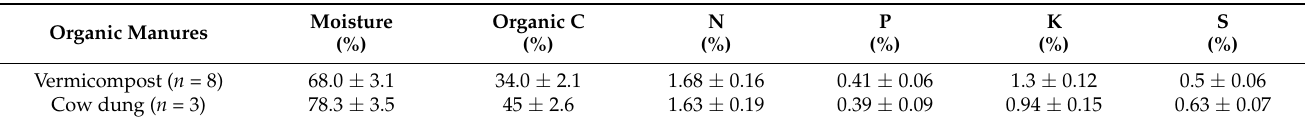
Table 2. Nutrient composition of organic